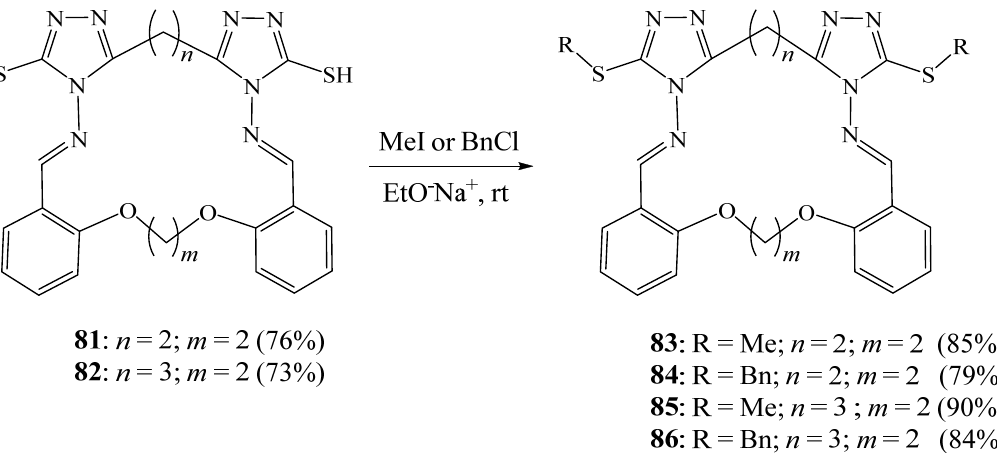
Figure 21. Alkylation of triazolic macrocycles 81 and 82. (Reprinted with permission from ref. [38]. Copyright 2009 © Georg Thieme Verlag KG).